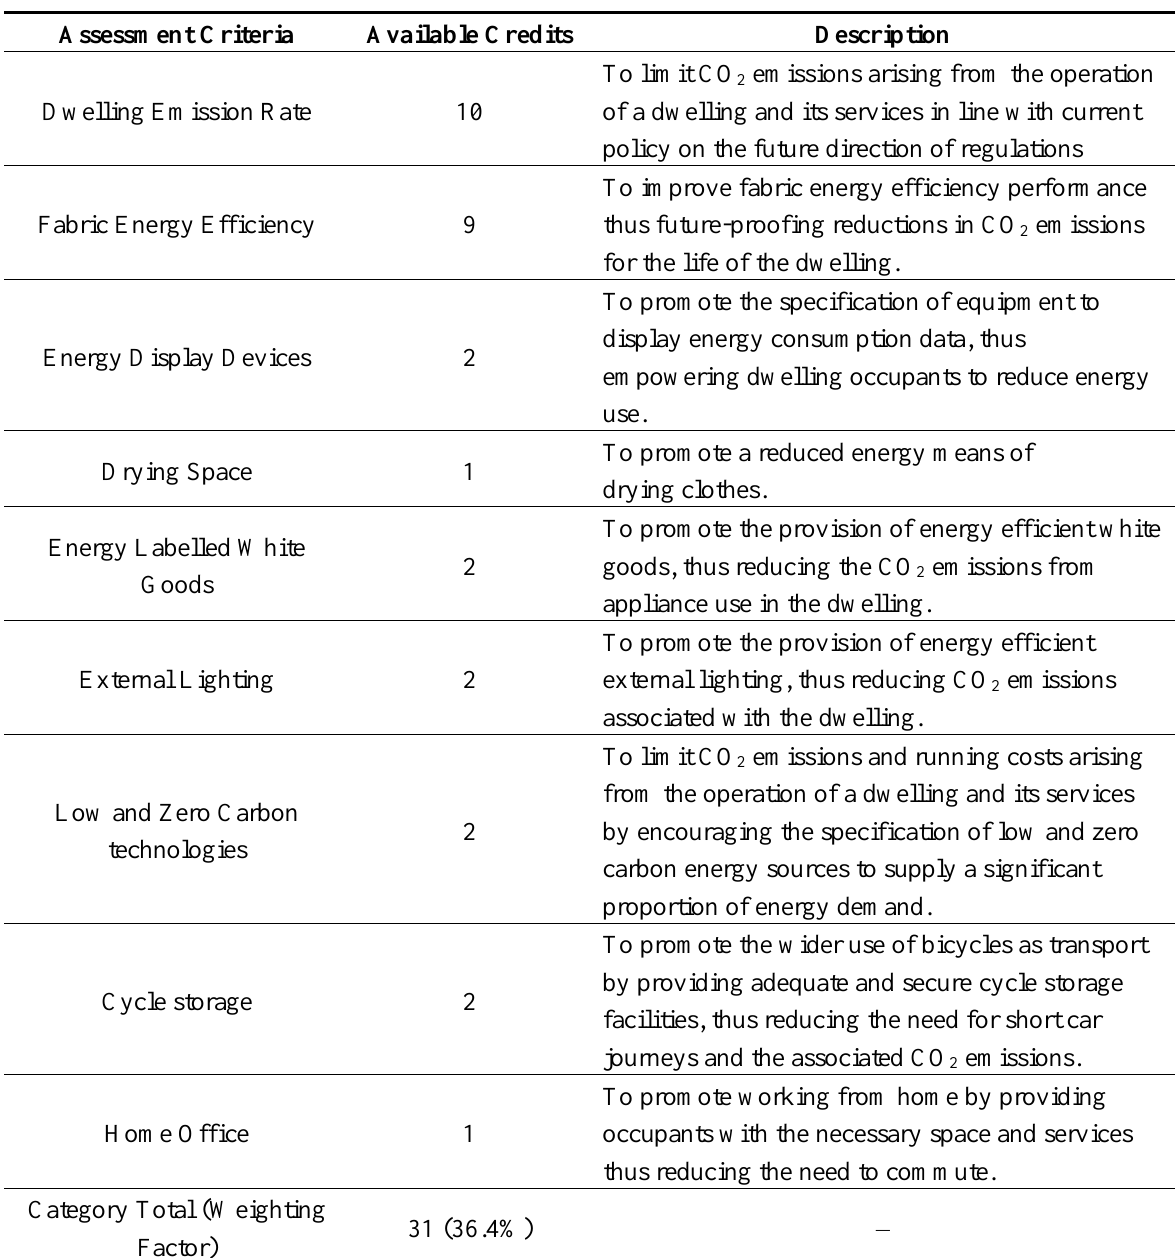
Table 3. The “Energy and CO 2 Emissions” category of the Code for Sustainable Homes. Data from